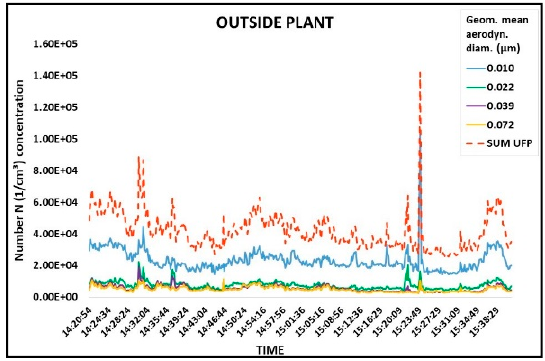
Figure 5. Time variation of UFP number concentrations (part/cm 3 ) by size measured with ELPI outside of the plant at a distance of 10 m from the electric arc furnace in the steel foundry. The x -axis represents sampling (hh:mm:ss) and the y -axis represents UFP number concentration (1/cm 3 ).